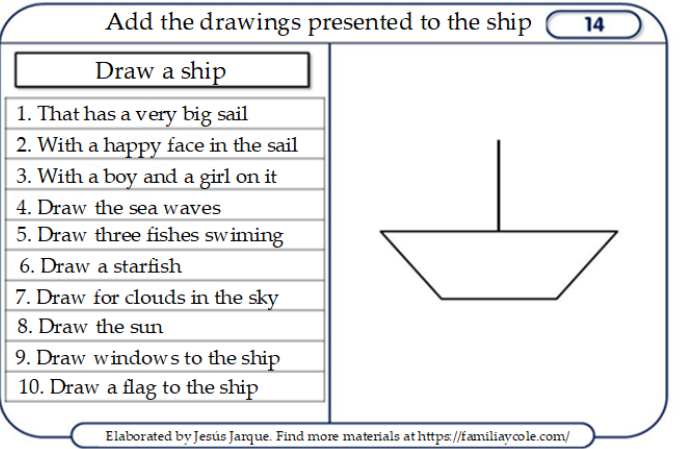
Figure 3. Example of reading, following instructions, and drawing activity sheet. This activity requires the child to read and follow instructions. The activity sheets are from https://familiaycole. com/, accessed on 29 December